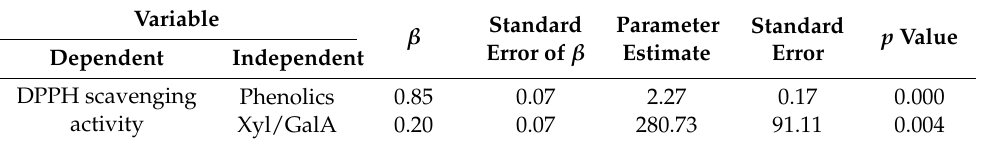
Parameter Standard Standard p Value β Estimate Error of β Error